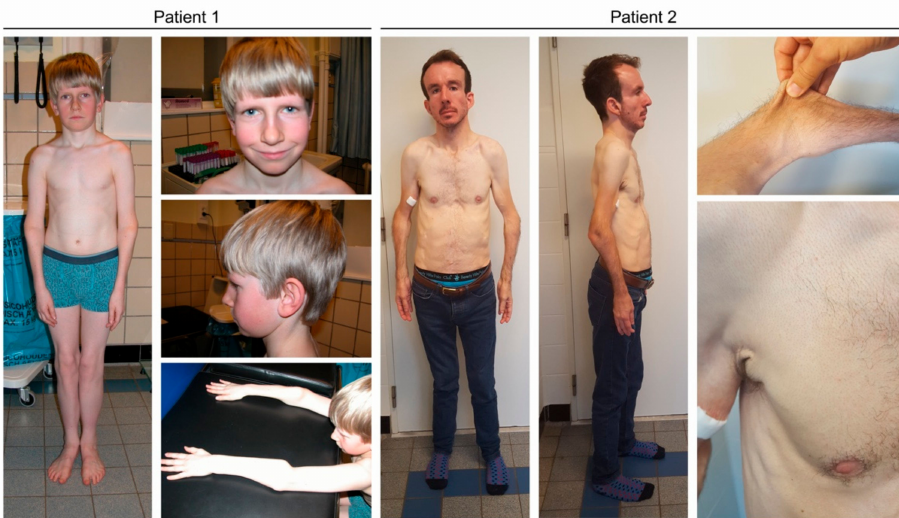
Figure 1. Clinical characteristics in subjects F1:II-1 and F2:II-1. Subject F1:II-1 displays mild facial dysmorphism with a flat face, deep-set eyes, a long and narrow nose, large ears and mild webbing of the neck. Craniofacial features in patient F2:II-1 are more pronounced and include dolichocephaly, a high forehead, biparietal narrowing, downslanting eyes, a convex nasal ridge, midfacial hypoplasia, micrognathia and low-set ears. No hair abnormalities were observed. Both have lax and hyperextensible skin, marked joint hypermobility and deformities of the proximal